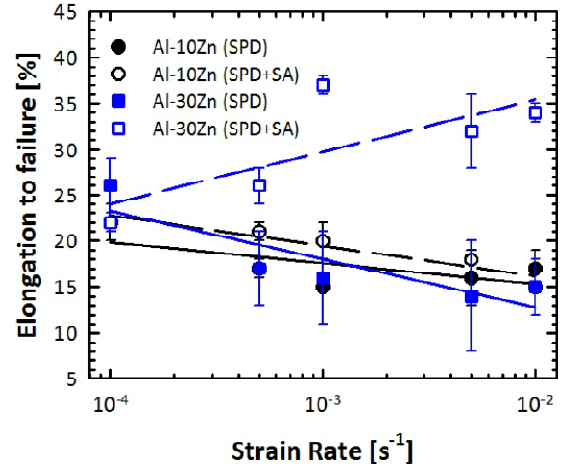
Fig. 6. Strain rate dependence of the elongation to failure of ultrafine grain Al-Zn alloys after severe plas- tic deformation (SPD) and after SPD followed by static annealing (SA) of 10 min at 200 ° C for Al- 10Zn and 10 min at 250 ° C for